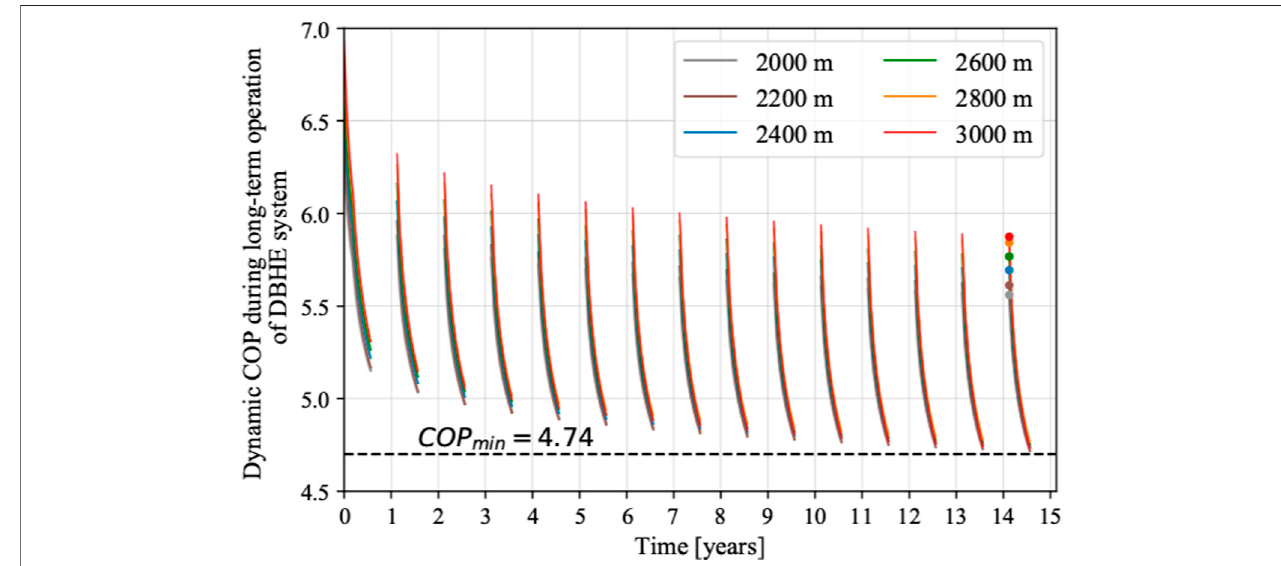
FIGURE 7 | Variation of COP for the DBHE heating system with different drilling depths.